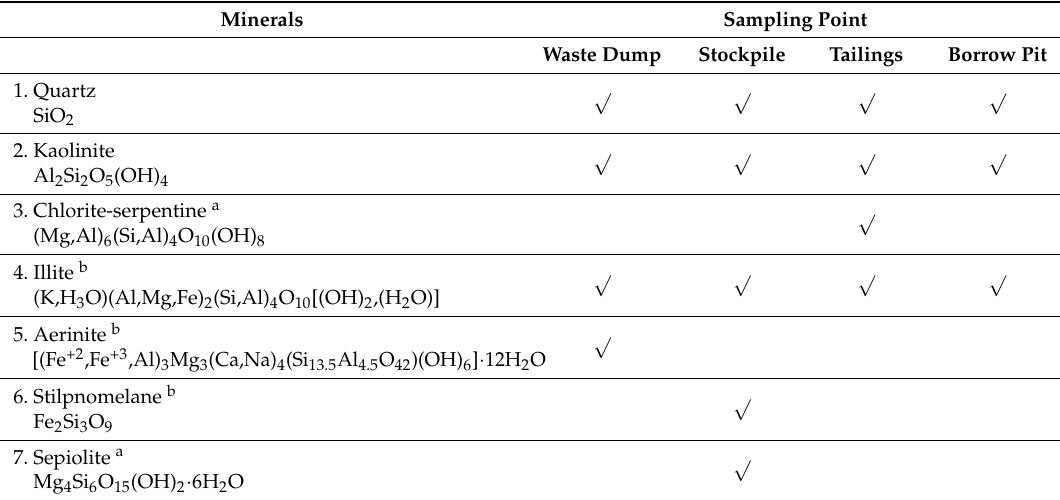
√ ) is referring to the presence of